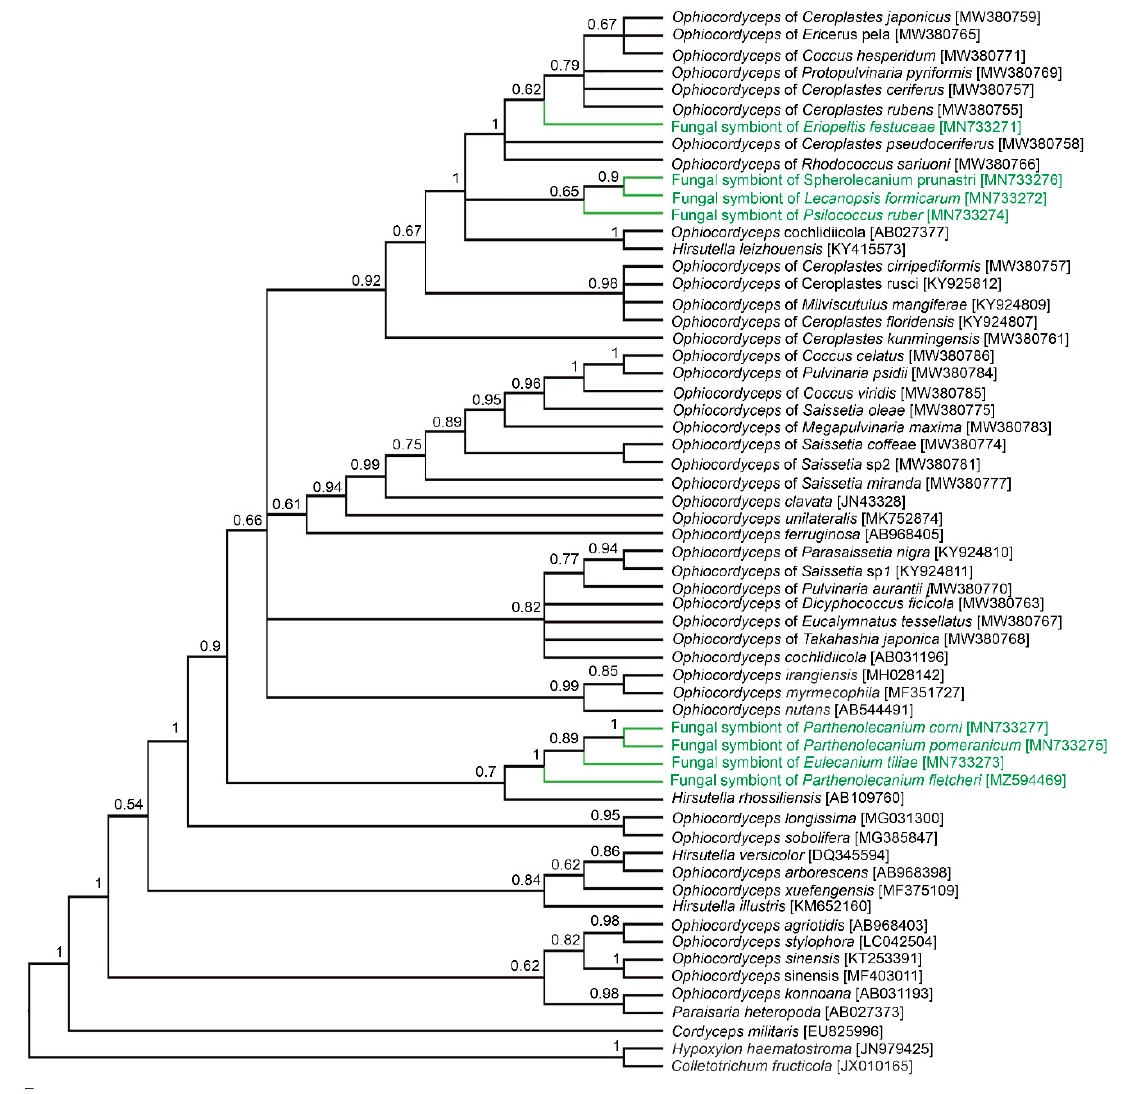
Figure 1. Phylogenetic tree showing the relationships between fungal symbionts of soft scale insect species, pathogenic, as well as free living fungi (constructed on the base of ITS2 genes). The numbers near the nodes refer to the Bayesian posterior probability.